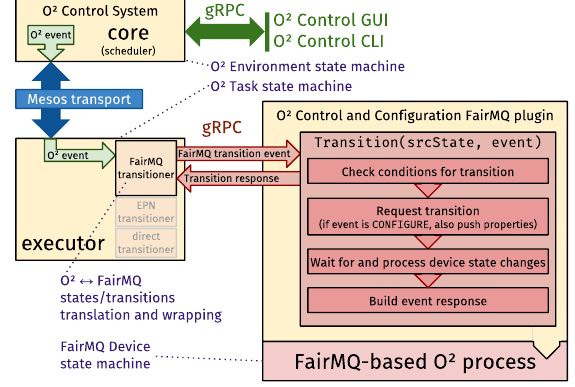
Figure 3. The O 2 control executor integrates modular components called transitioners . These units act as translation wrappers between O 2 control states and events, and the states and events of the state machine of a specific controlled process. In the figure above the executor has loaded the FairMQ transitioner, which drives the state machine of a FairMQ-based process.